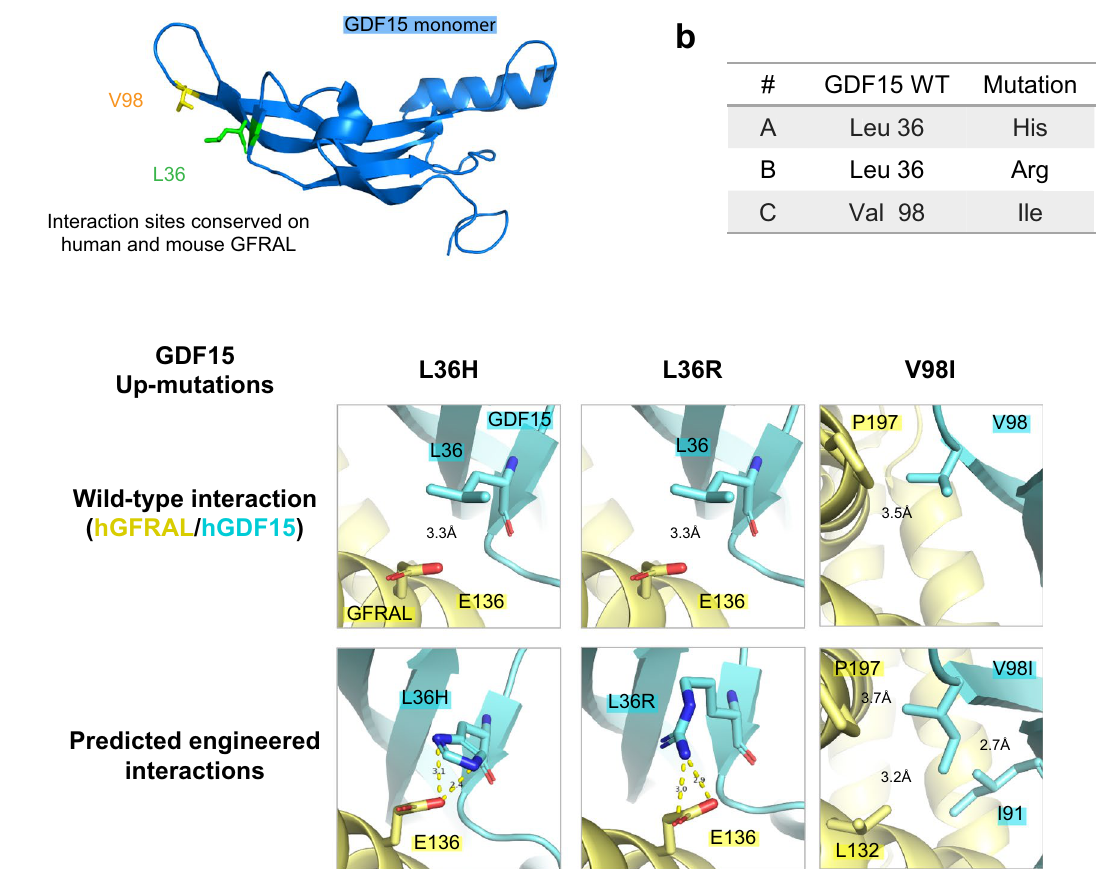
Figure 3. Introduction of point mutants to improve GFRAL binding affinity. ( a ) Structure of GDF15 monomer. Highlighted residues at the GFRAL binding site were selected for mutation (PDB 5VZ4). ( b ) GDF15 point mutations designed to improve GFRAL binding affinity. ( c ) Predicted engineered interactions modeled on GDF15-GFRAL crystal structure (PDB 5VZ4). Wildtype interaction shown above. Theoretical up-mutant interactions shown below. Blue, hGDF15. Yellow, hGFRAL. Yellow dashed lines denote predicted hydrogen bonding interactions. Figures rendered using The PyMOL Molecular Graphics System, Version 2.0 Schrödinger, LLC (https:// pymol.